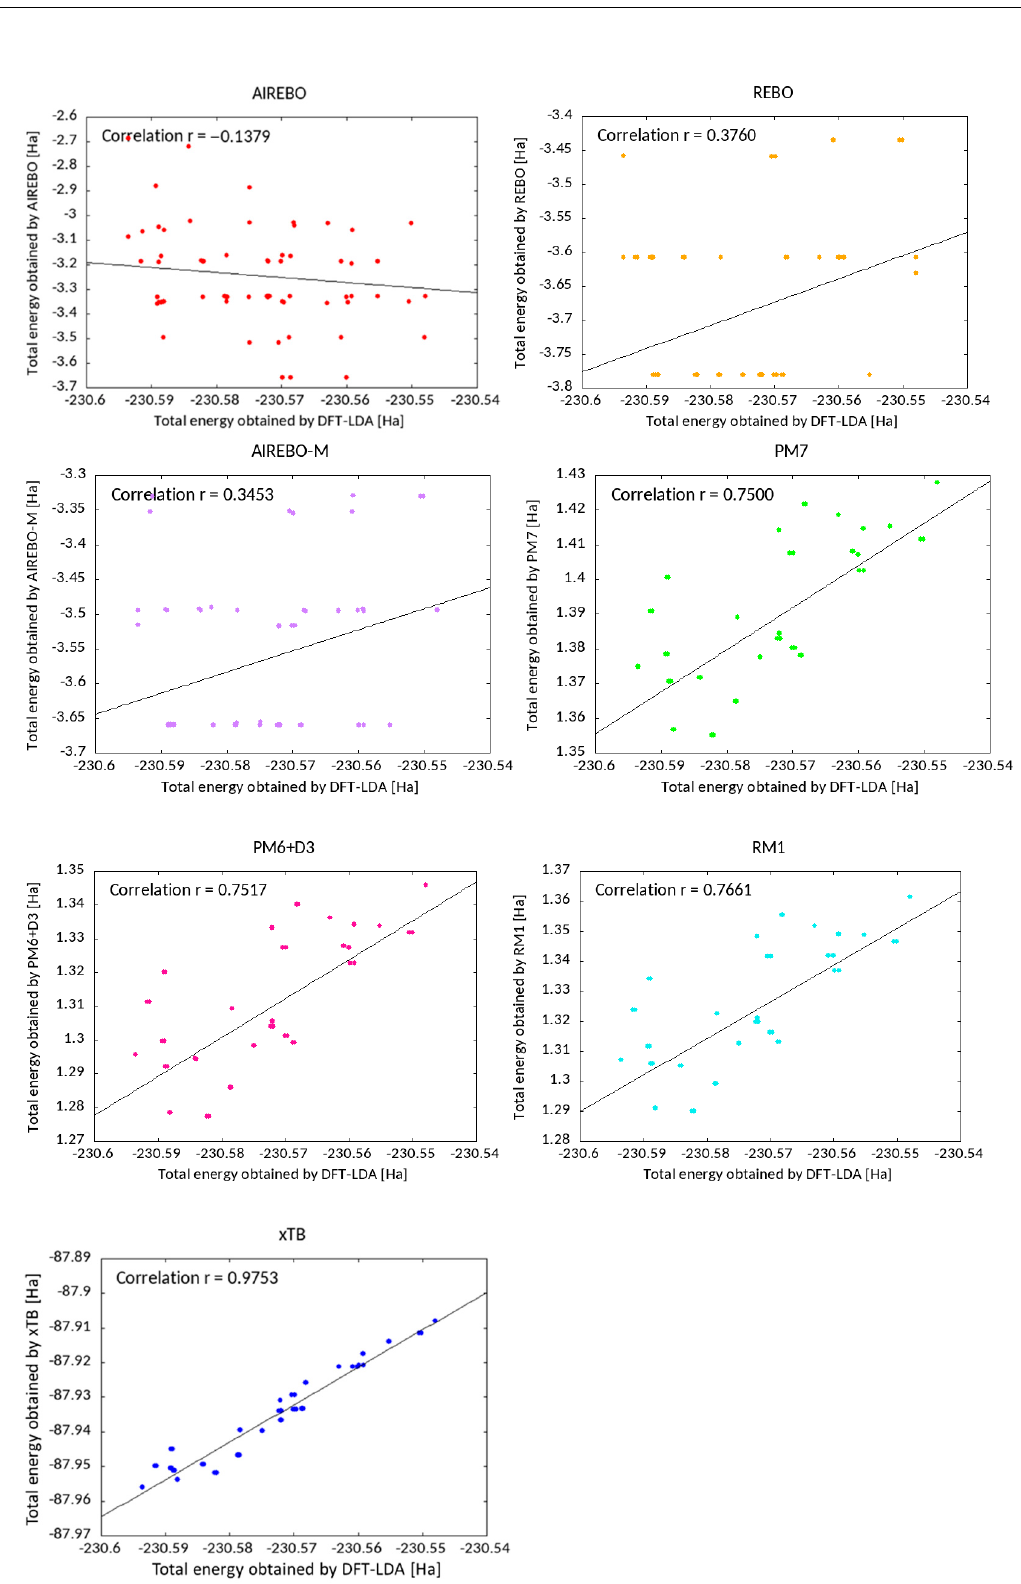
Figure 7. Total energy correlation plots for isomers of C 40 H 5 . Energy obtained by DFT-LDA is plotted along the x-axis and by empirical and semi-empirical methods along the y-axes as labelled. Linear correlation in each model is shown as r in each plot.